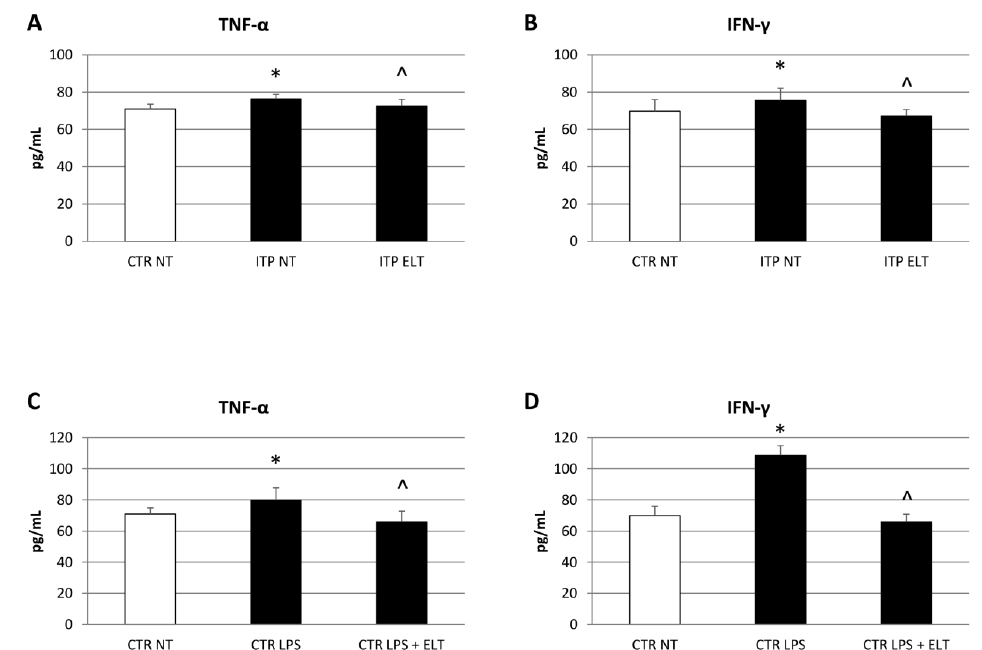
Figure 3. Effect of ELT on Tumor Necrosis Factor- α (TNF- α ) and Interferon- γ (IFN- γ ) release. ( A , B ) TNF- α and IFN- γ concentrations (pg/mL) in ITP macrophages compared with CTR NT macrophages, determined by enzyme-linked immunosorbent assay (ELISA Assay), after treatment with ELT (6 µ M). Histogram shows TNF- α and IFN- γ concentrations as the mean ± S.D. of independent experiments on each individual sample. The cytokines concentration was determined on a standard concentration curve according to the manufacturer’s instructions. A t -test was used for statistical analysis. * indicates p ≤ 0.05 compared to CTR NT, ˆ indicates p ≤ 0.05 compared ITP NT. ( C , D ) TNF- α and IFN- γ concentrations (pg/mL) in ITP macrophages compared with CTR macrophages, determined by ELISA Assay, after treatment with LPS (500 nM) and LPS combined with ELT (6 µ M). Histogram shows TNF- α and IFN- γ concentrations as the mean ± S.D. of independent experiments on each individual sample. The cytokines concentration was determined on a standard concentration curve according to the manufacturer’s instructions. A t -test was used for statistical analysis. * indicates p ≤ 0.05 compared to CTR NT, ˆ indicates p ≤ 0.05 compared to CTR LPS.